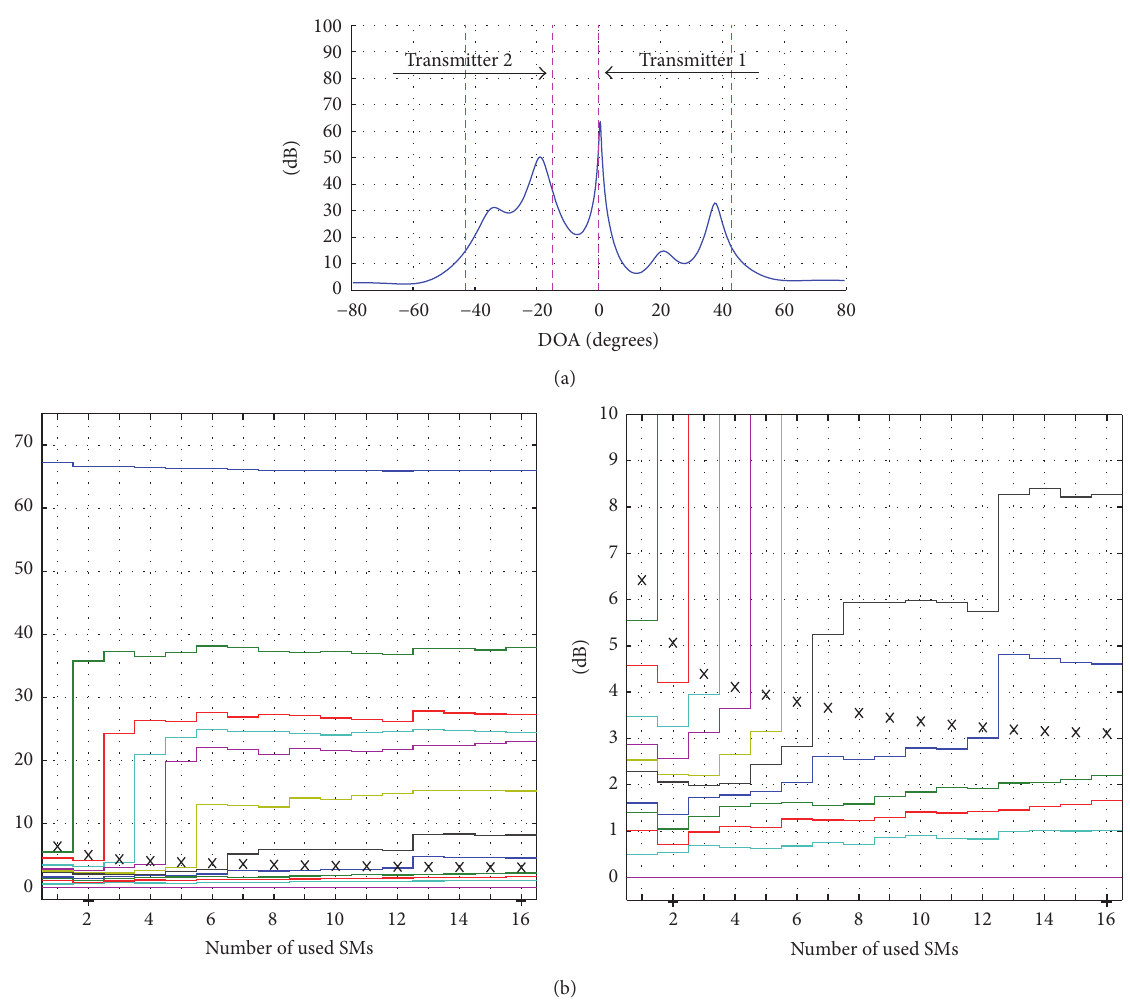
Figure 9: Measurement C2SS. Two coherent strong transmitters. (a) Capon DOA spectrum. (b) Eigenspectrum. Zoom-in to the right. dB scale. See Section 3.3 for